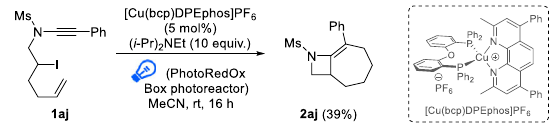
Fig. 5 Cascade radical 4-exo-dig/7-endo-trig cyclization to bicyclic azetidine 2aj. Reaction conditions: ynamide 1aj (0.2 mmol), [Cu(bcp) DPEphos]PF 6 (5 mol%), ( i -Pr) 2 NEt (2 mmol), MeCN (0.1 M), r.t., 16 h. Isolated yield is